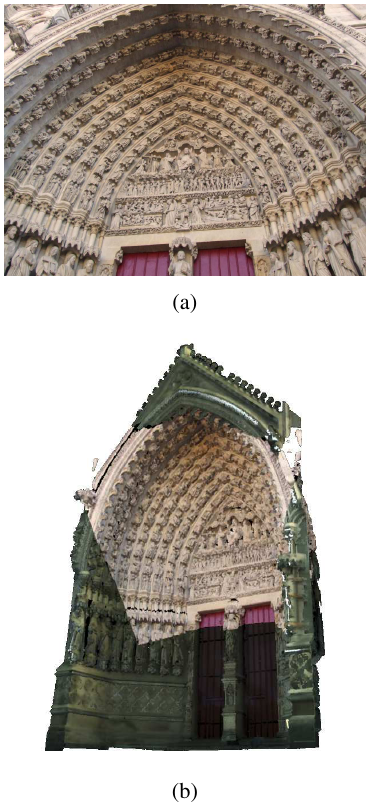
Figure 14: (a) Digital image of a part the western fac¸ade portal from the internet. (b) Point cloud of the western faade portal with points colored using the digital